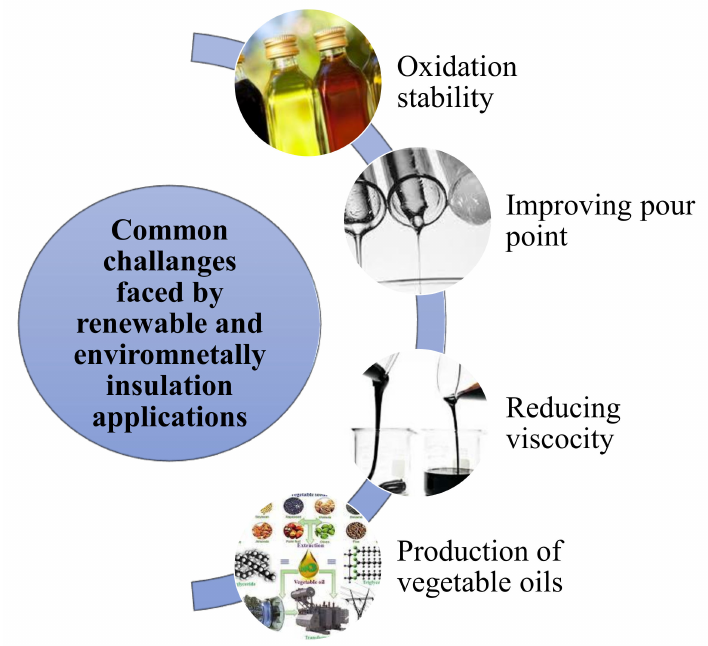
Figure 6. Common challenges related to environmentally friendly insulation fluids for HV applications.